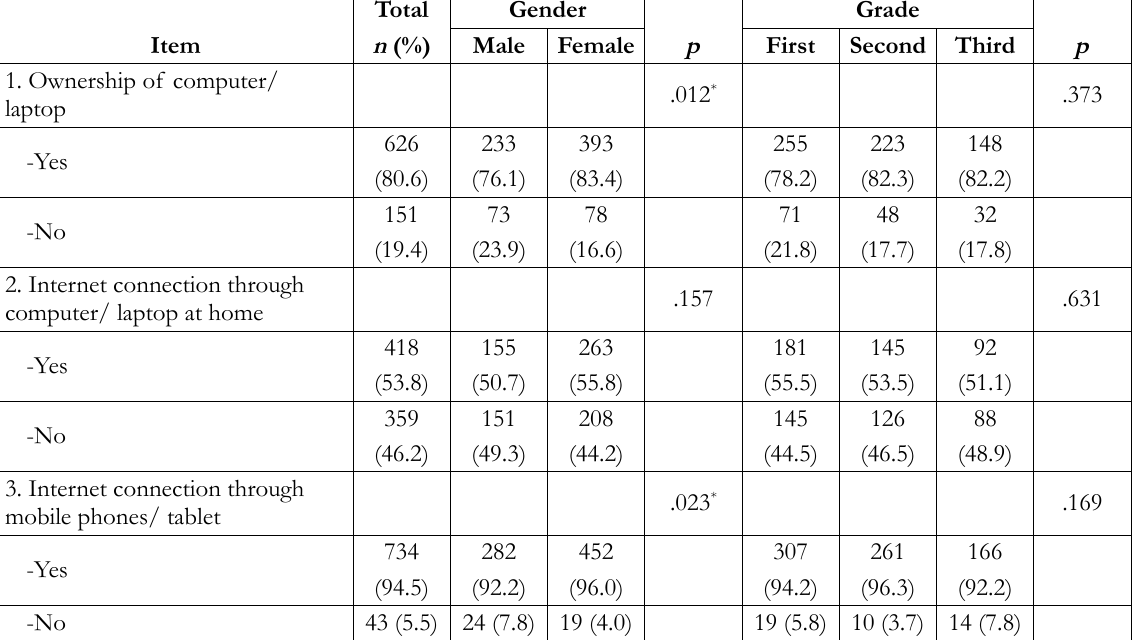
Table 1. Computer and internet access ownership at